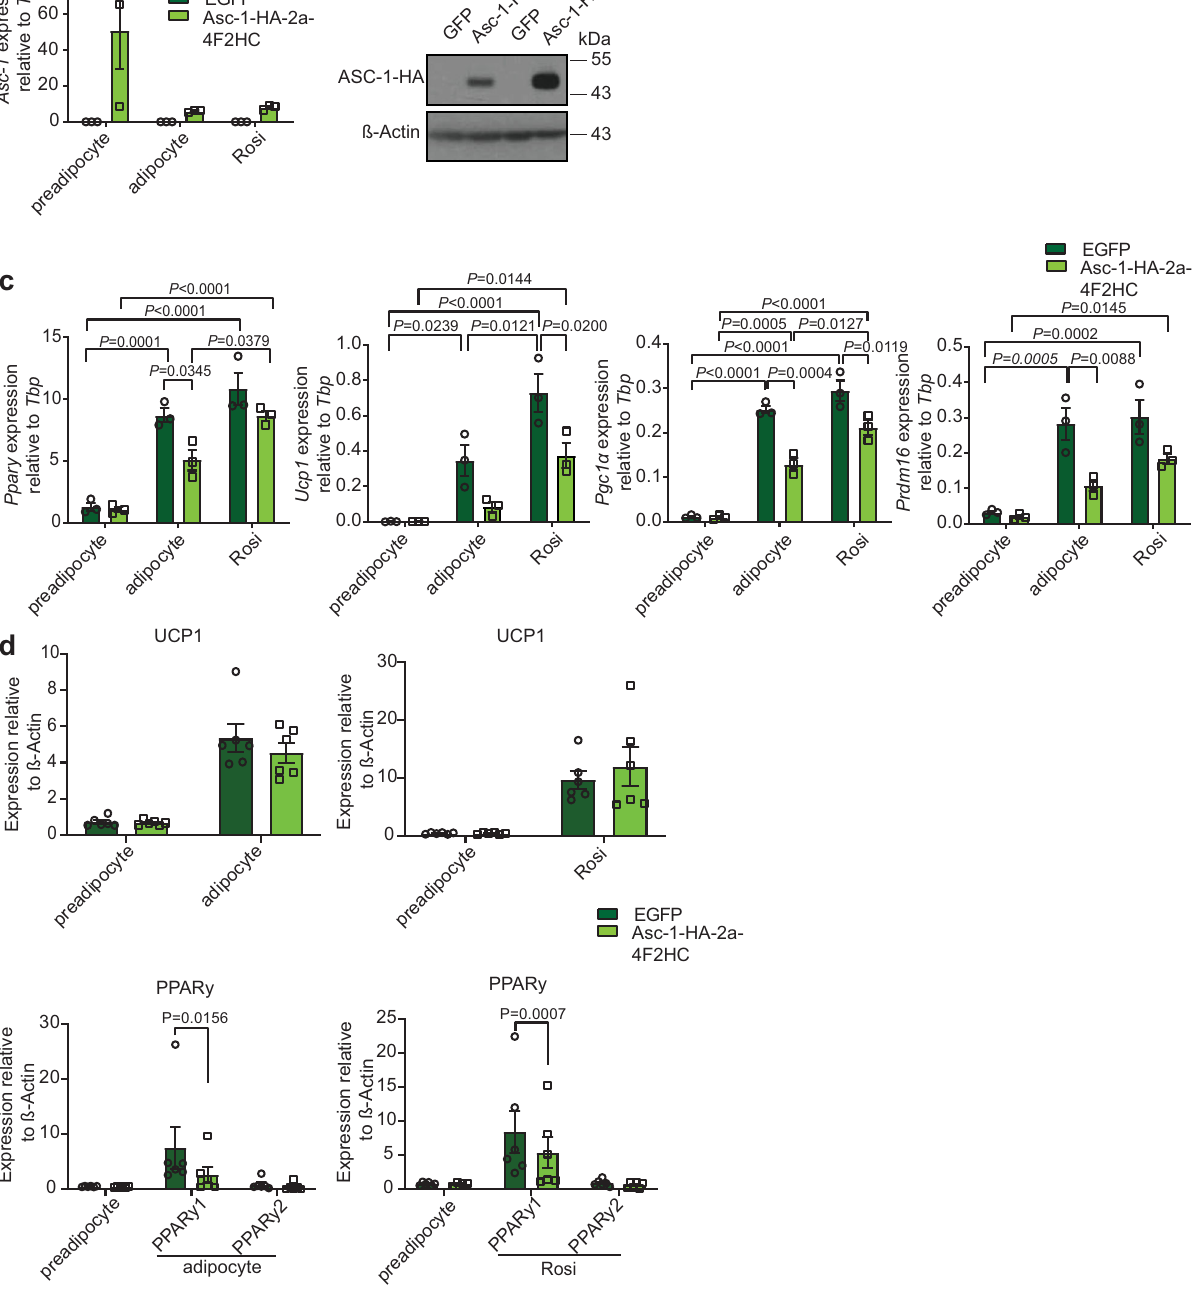
Fig. 3 Overexpression of Asc-1 in brown (pre-)adipocytes suppresses thermogenic gene expression. a Asc-1-HA-2a-4F2HC or EGFP overexpressing brown preadipocytes were grown to 100% con fl uence, and RNA or protein was collected from the day of differentiation start (preadipocyte), and after 8 days of differentiation with (Rosi) or without rosiglitazone (adipocyte) and relative gene expression of Asc-1 measured ( n = 3). b Western blot of ASC-1- HA (45 kDa) and β -actin (42 kDa; n = 2). c Relative gene expression of Ppary ( n = 3), Ucp1 ( n = 3), Pgc1 α ( n = 3), and Prdm16 ( n = 3). d Quanti fi cation of PPARy1 and 2 and UCP1 (33 kDa) protein levels relative to β -actin (42 kDa; n = 6, only preadipocyte in Ppary blot of Rosi n = 4). The same preadipocyte samples were used as controls for the different differentiation conditions. Statistics were calculated using two-way ANOVA with Tukey ’ s or Sidak ’ s (for a , Pgc1 α in c , and Ucp1 and Ppary1 – 2 for adipocyte in d ) or two-way ANOVA mixed-effects analysis (Ppary1 – 2 for Rosi in d ) multiple comparison post hoc test. Data are shown as mean ±